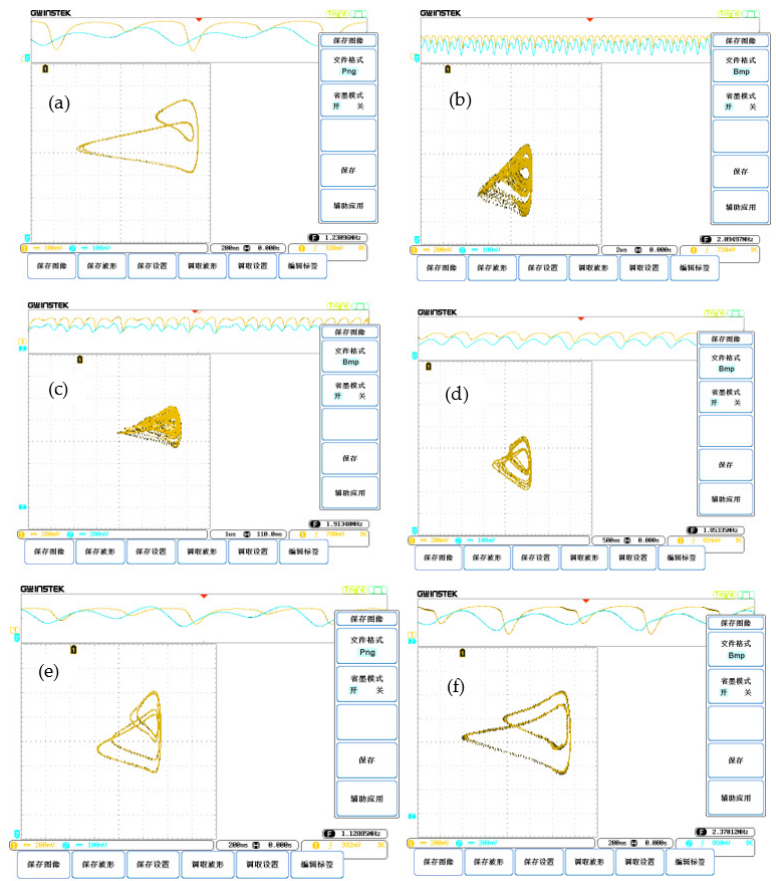
on the right of the figure means (from top to down): save image, file format Bmp, Ink-saving mode (open, off), save, and assistant function; The Chinese characters on the bottom of the figure means (from left to right): save image, save waveform, save setting, modulate waveform, and edit tag.